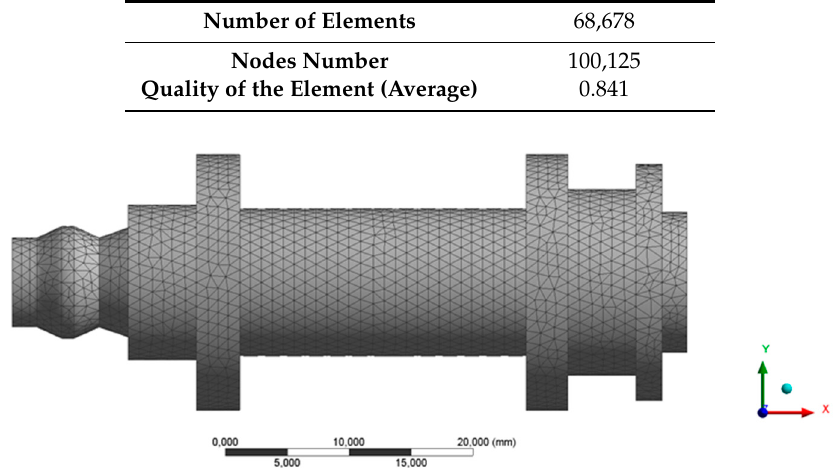
Table 11. Statistics of the mesh generated for the mechanical modeling.